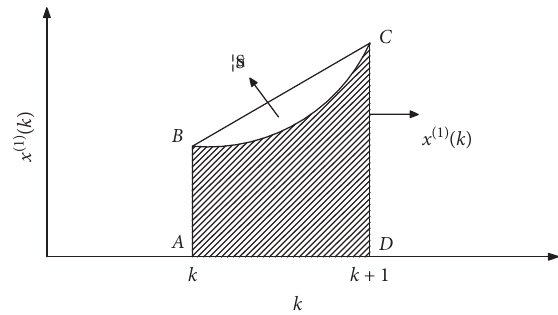
Figure 1: Error generating mechanism of background value.